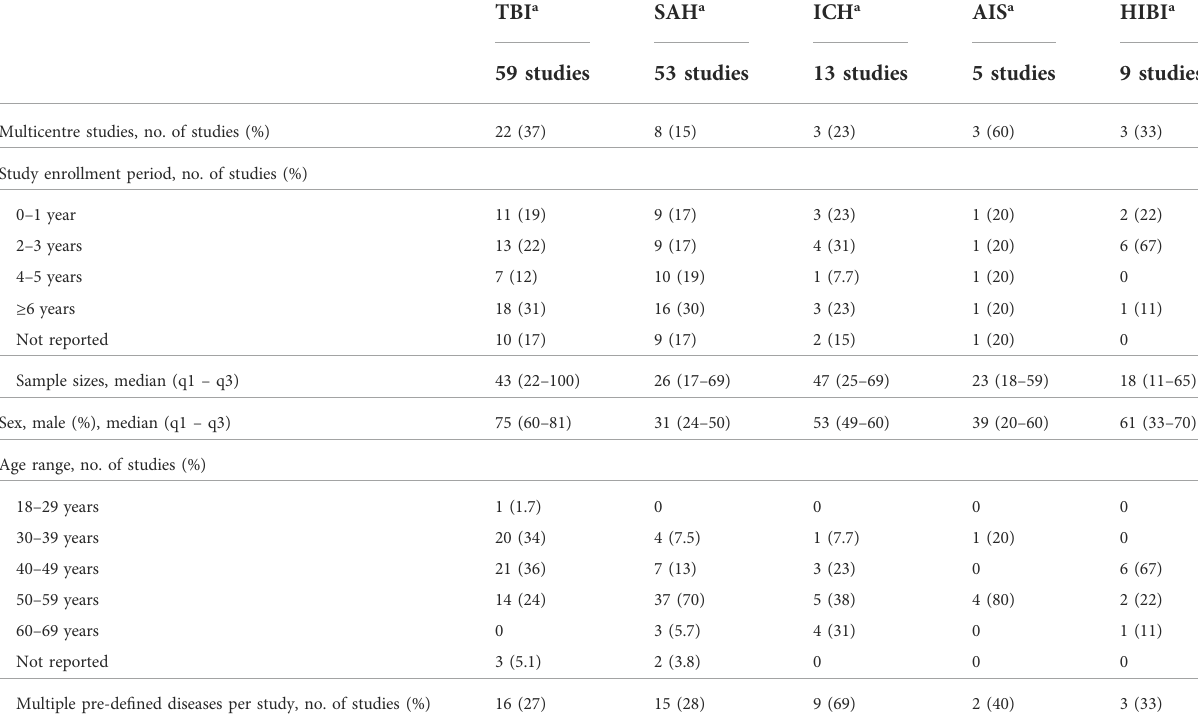
TABLE 2 Study setting, and clinical characteristics of cerebral multimodality monitoring studies (112 studies).